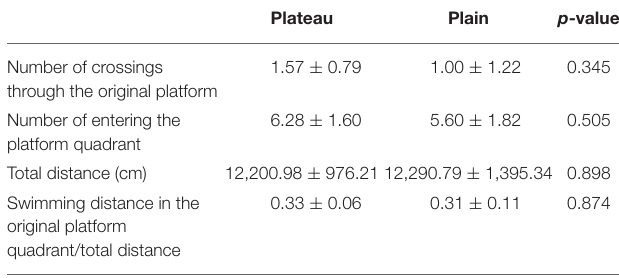
TABLE 5 | Analysis of the reversal phase of the Morris water maze. Plateau Plain p